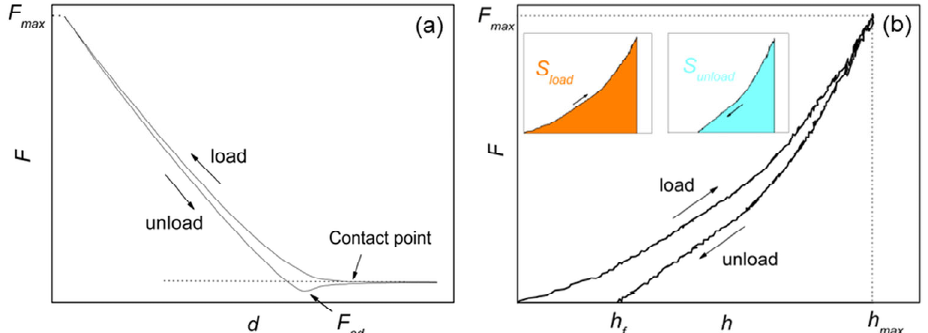
Figure 1. ( a ) F ‐ d curve with indication of the contact point and adhesion force F ad . ( b ) Force ‐ penetra ‐ tion ( F ‐ h ) curve equivalent to F ‐ d , with indication of the effective and maximum penetration depths h f and h max and the maximum force load F max = F ( h max ). In the inset, the areas under the load (S load ) and unload (S unload ) curves are evidenced in colors.